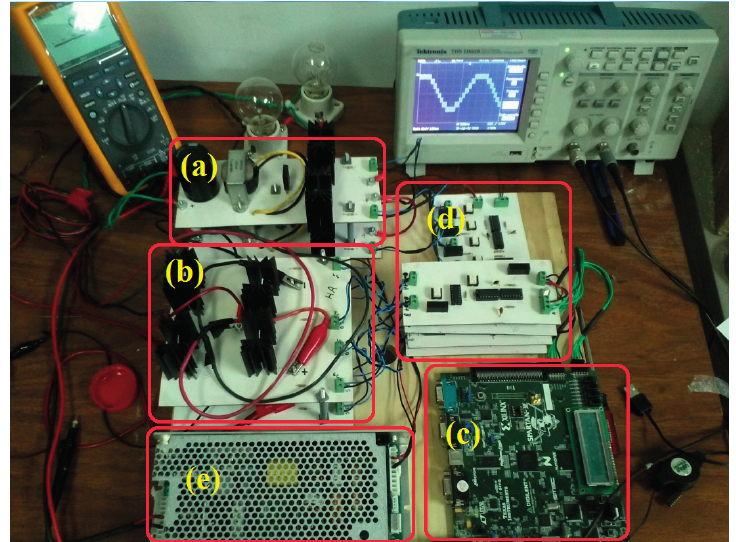
Figure 15. Laboratory prototype of the converter and experimental testing ( a ) Modified DC/DC buck converters; ( b ) H-bridges converters; ( c ) FPGA based control; ( d ) Drivers pulses for IGBTs; and ( e ) DC source circuitry.